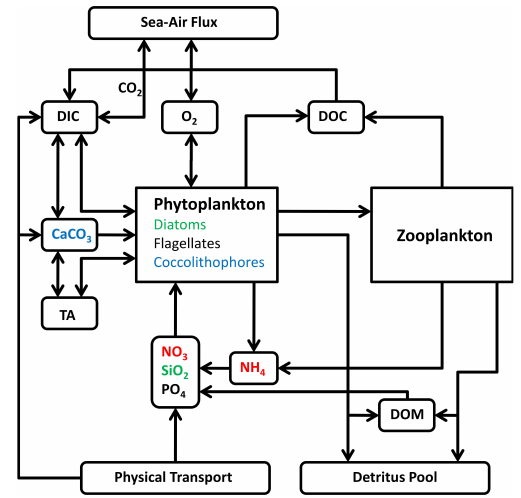
Fig. 4. Diagram of main components of the one-dimensional bio- geochemical model. The color code for some of the variables in- dicates unique association of processes, e.g., ammonium nitrifica- tion, uptake of silica by diatoms only, and calcification by coccol-